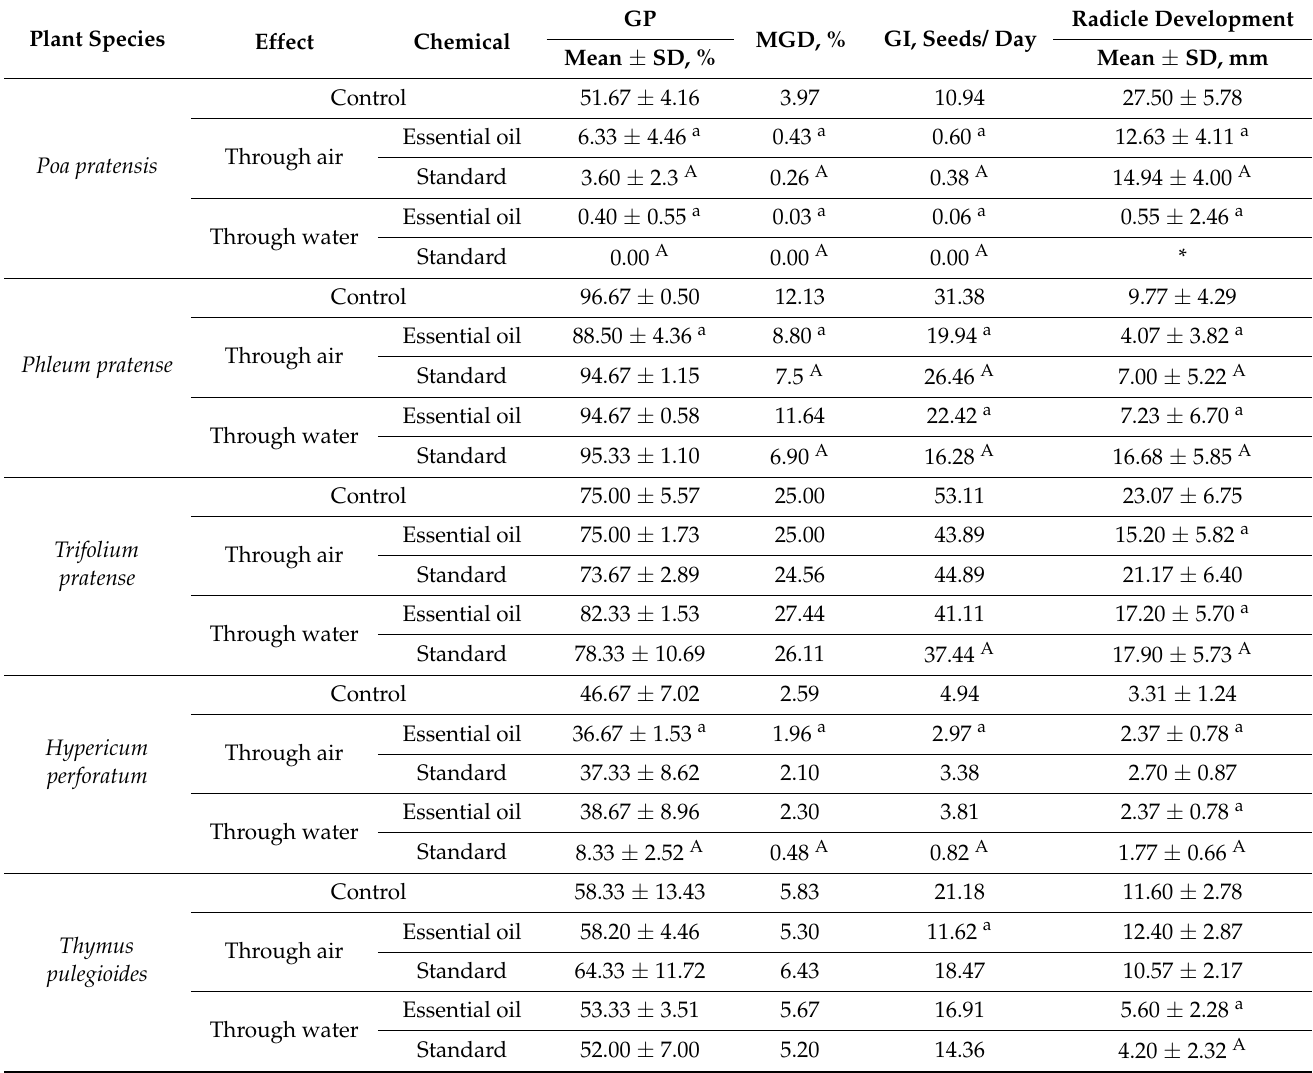
Table 4. Effects of essential oils of Thymus pulegioides α -terpinyl acetate chemotype and analytical standard of α -terpinyl acetate through air and water on germination of Poa pratensis, Phleum pratense, Trifolium pratense, Hypericum perforatum , and Thymus pulegioides (GP—germination percentage, MGD—mean daily germination, GI—germination index, SD—standard deviation). Letters denote statistically significant ( p < 0.05) differences: lower letters—between essential oil and control, capital letter—between analytical standard and